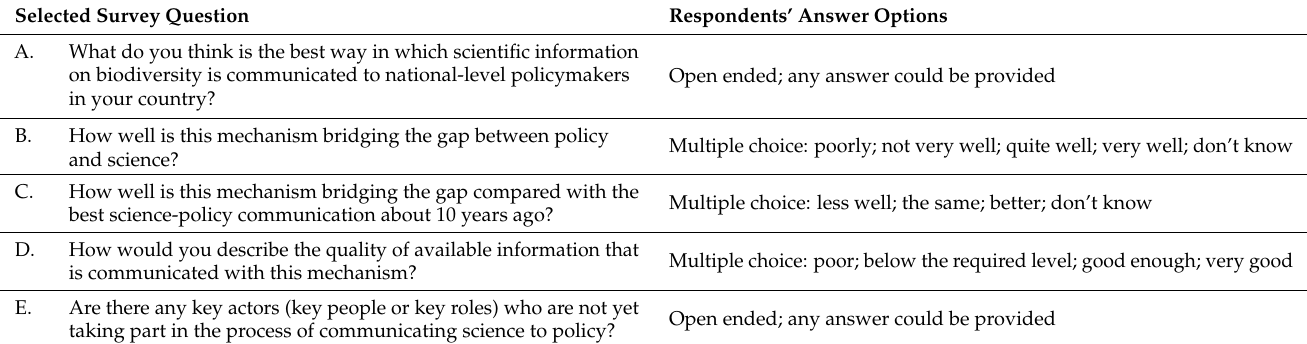
Table 1. Selected questions, and their answer options, for the survey on perceptions about the biodiversity science- policy